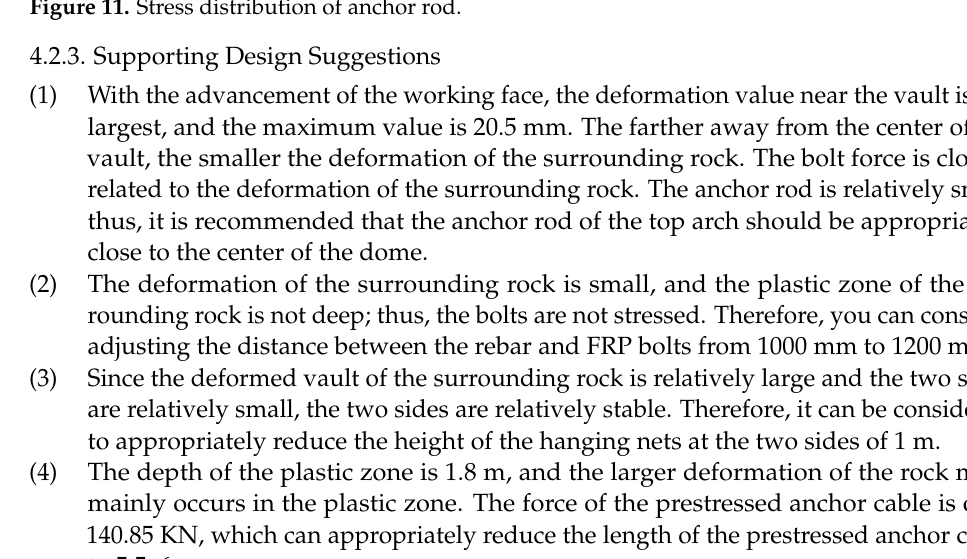
Figure 11. Stress distribution of anchor